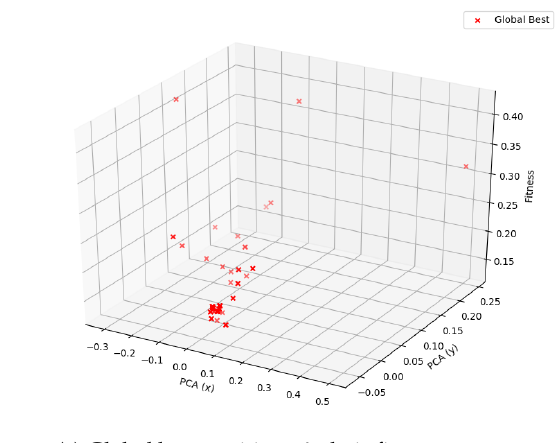
Figure 8. Example local and global best positions over time with the BLSK-NS weight inheritance method (PCA for dimensionality reduction to display particle positions on two axes with fitness on the third).